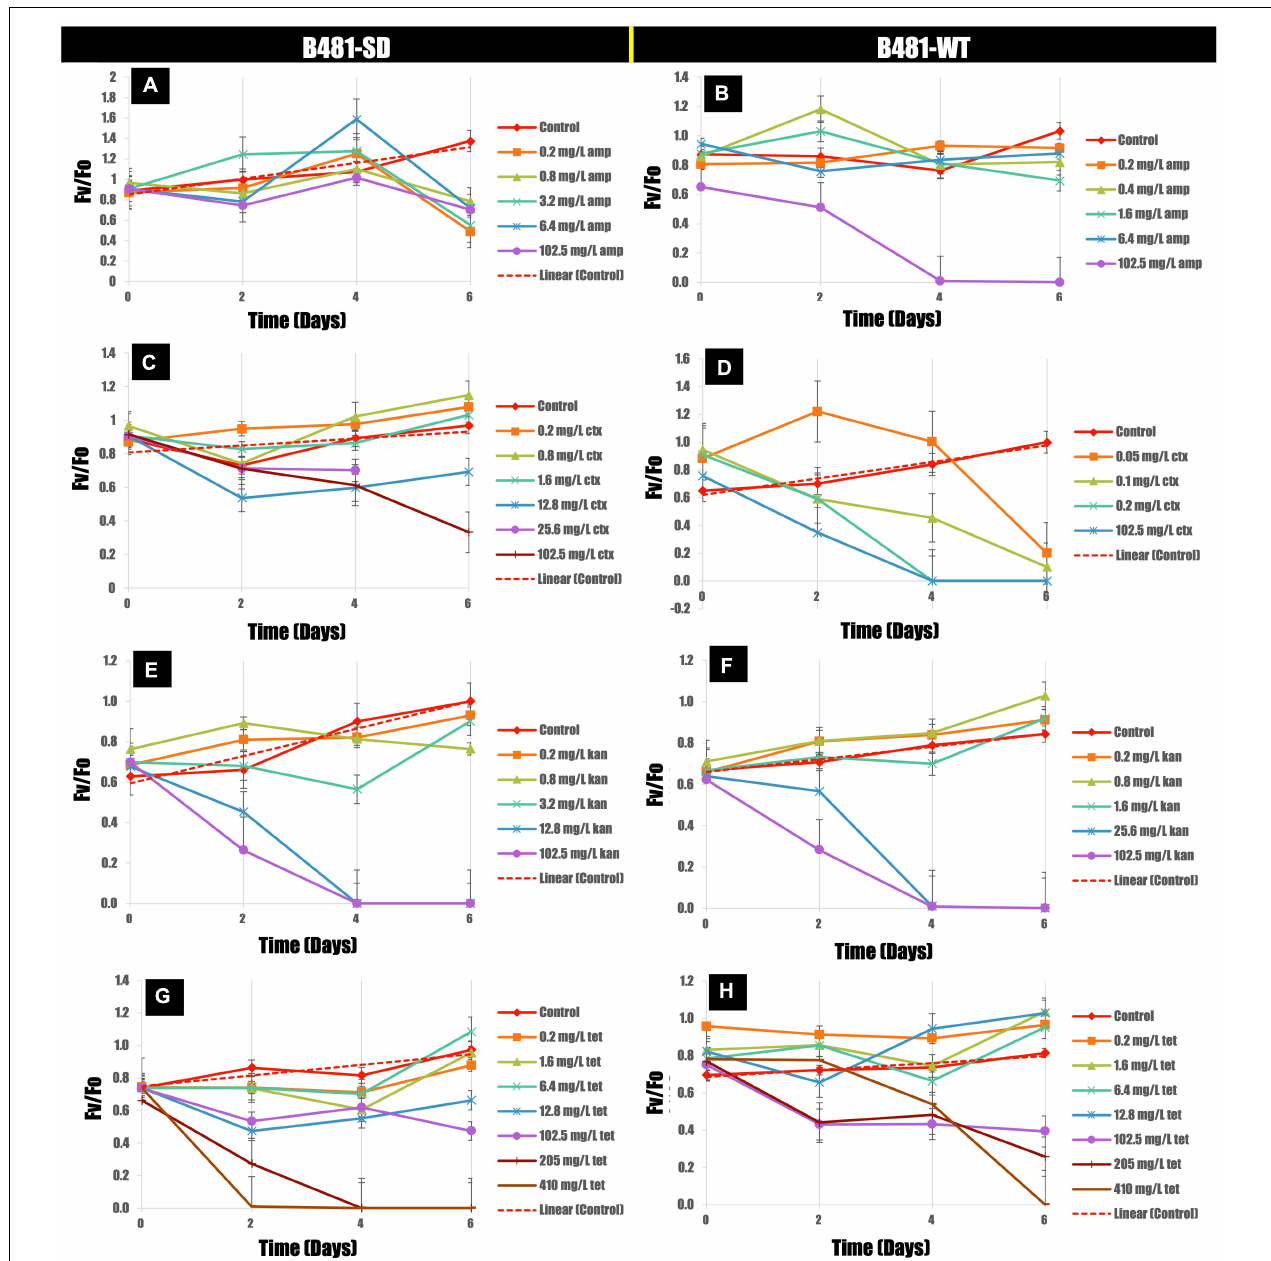
FIGURE 3 | Variance of Fv/Fo in B481-SD (A,C,E,G) and B481-WT (B,D,F,H) strains of Fremyella diplosiphon in response to ampicillin, cefotaxime, kanamycin, and tetracycline exposure for 6 days. Mean and standard deviations are indicated by error